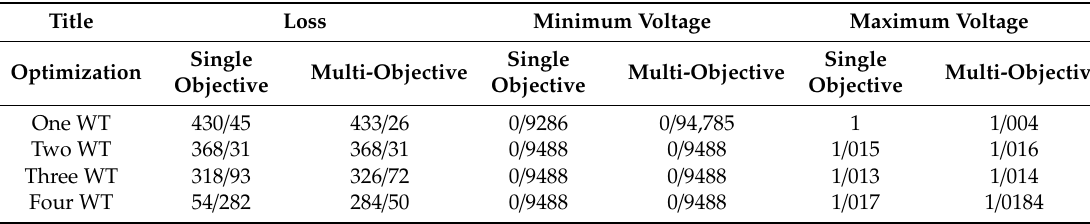
Table 3. Comparison of losses and single and multi-objective optimization